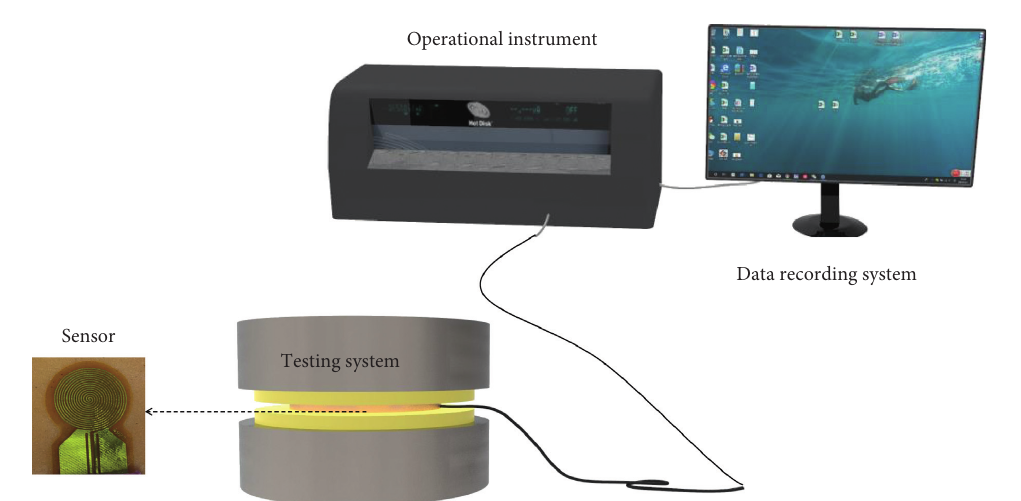
Figure 4: Hot Disk TPS 2500 S thermophysical conductivity analyzer.